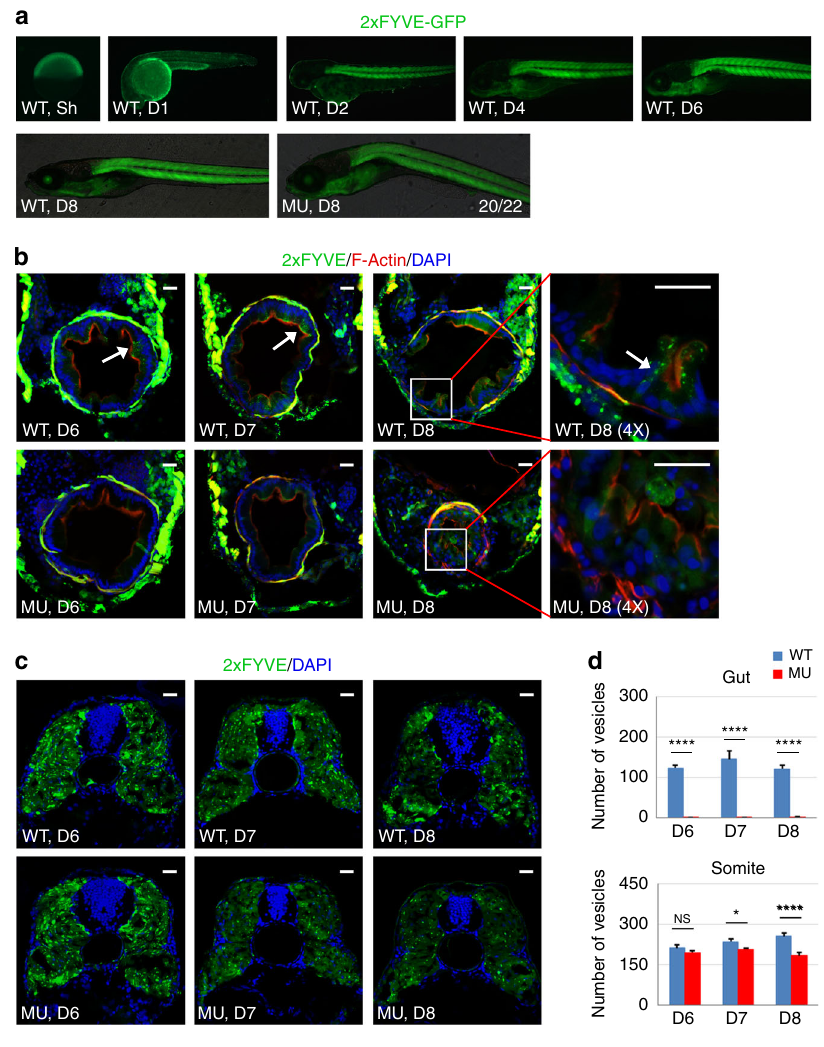
Fig. 5 PI3P-positive vesicles are reduced in mutant IECs. a Represent images of transgenic zebra fi sh expressing the PI3P probe 2xFYVE-GFP under the control of ubiquitin promoter. Sh shield stage. b Cross sections of embryos at 6 – 8 dpf. PI3P-positive vesicles (arrow) are detectable in WT IECs, while the GFP signal in mutant IECs is weak and diffused. Scale bar, 20 µ m. c PI3P-positive vesicles in somitic corss sections. Scale bar, 20 µ m. d Quanti fi cation of PI3P-positive vesicles in ( b , c ). Data represent mean ± SD from three biological repeats (NS, non-signi fi cant; * p < 0.05; **** p < 0.0001 in one-way ANOVA with Tukey ’ s multiple